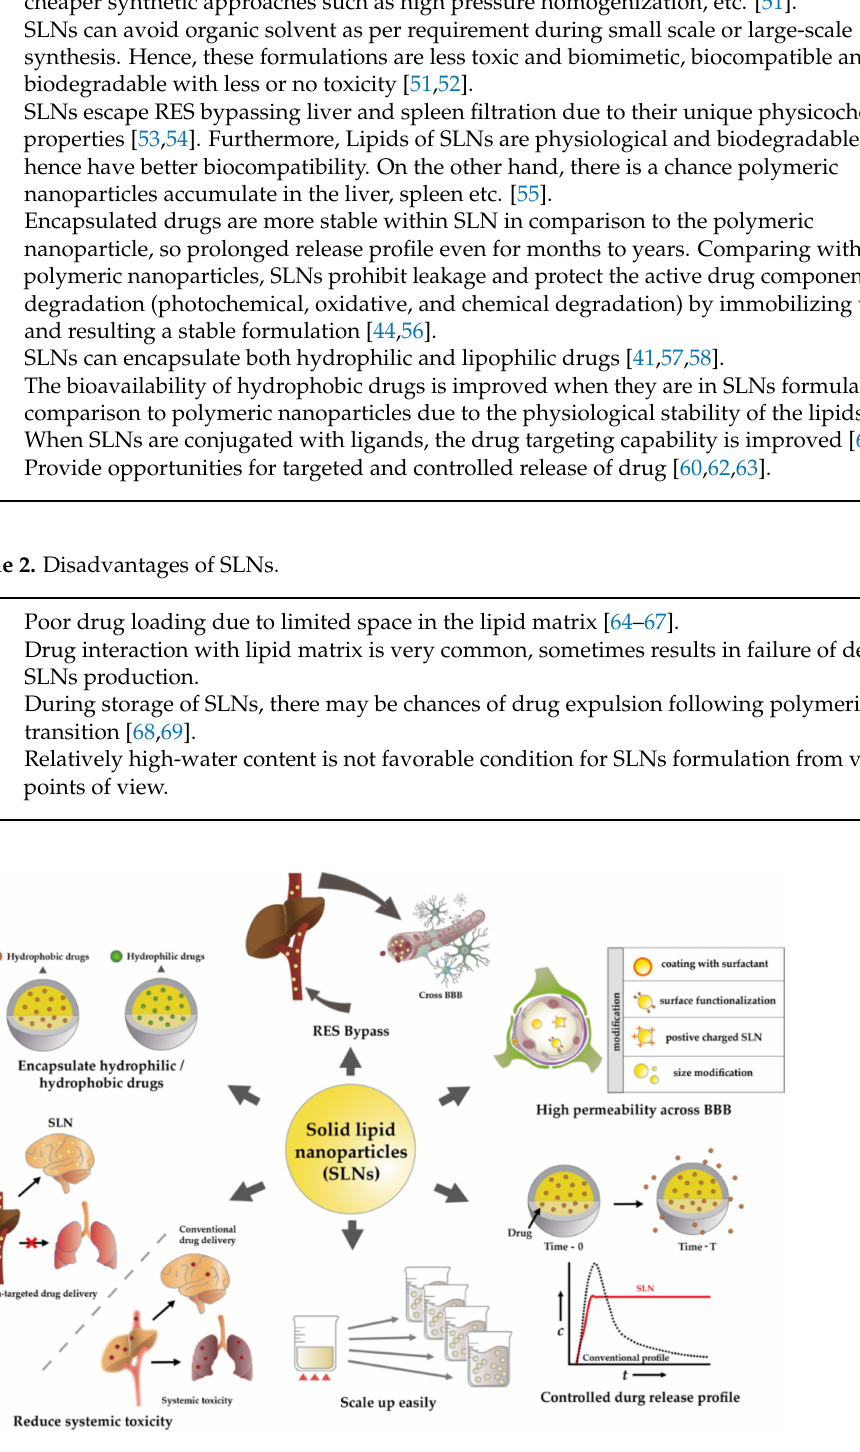
Figure 3. Highlighting the utilities of SLNs and their modifications such as: encapsulation of hydrophilic and lipophilic drugs, capable to cross the BBB for target specific drug delivery due to their unique physicochemical nature, can bypass RES system, reduce systemic toxicity, sustained or controlled drug release in a time dependent manner, and can be scaled up in a cost-effective